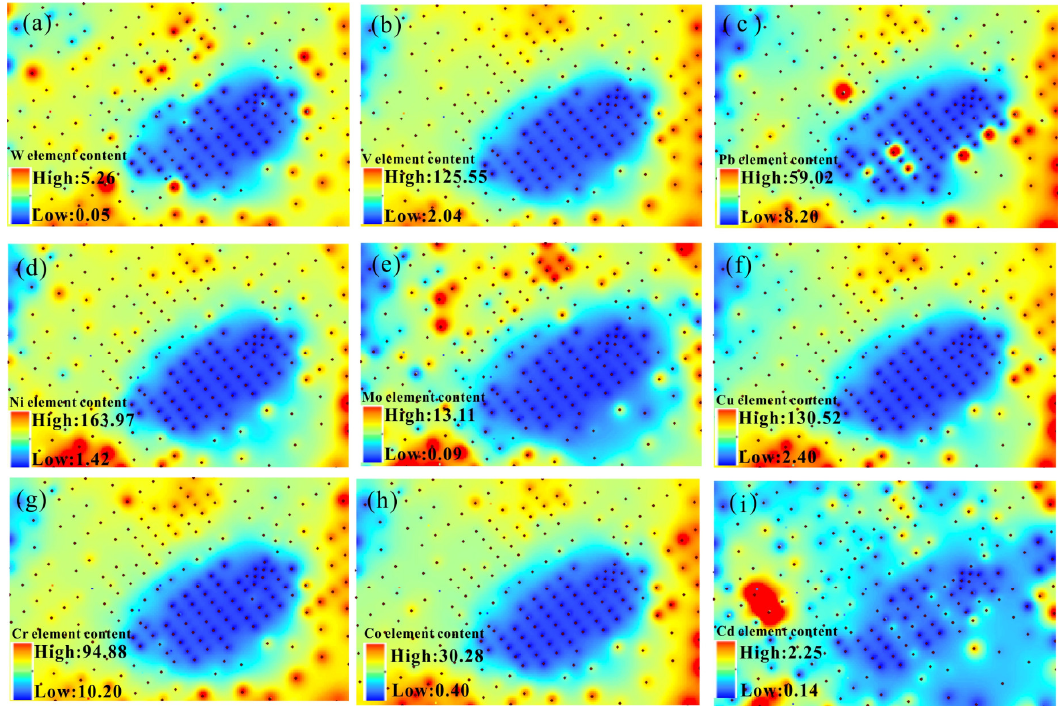
Figure 3. Maps of raw data of W, V, Pb, Ni, Mo, Cu, Cr, Co, and Cd, represented by ( a – i ), respectively.